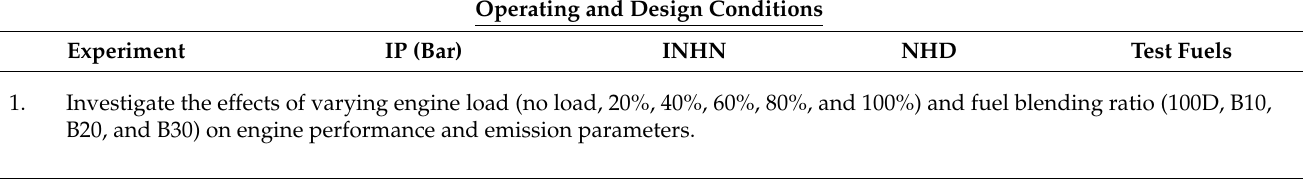
Table 6. The test matrix for the experimental analysis.